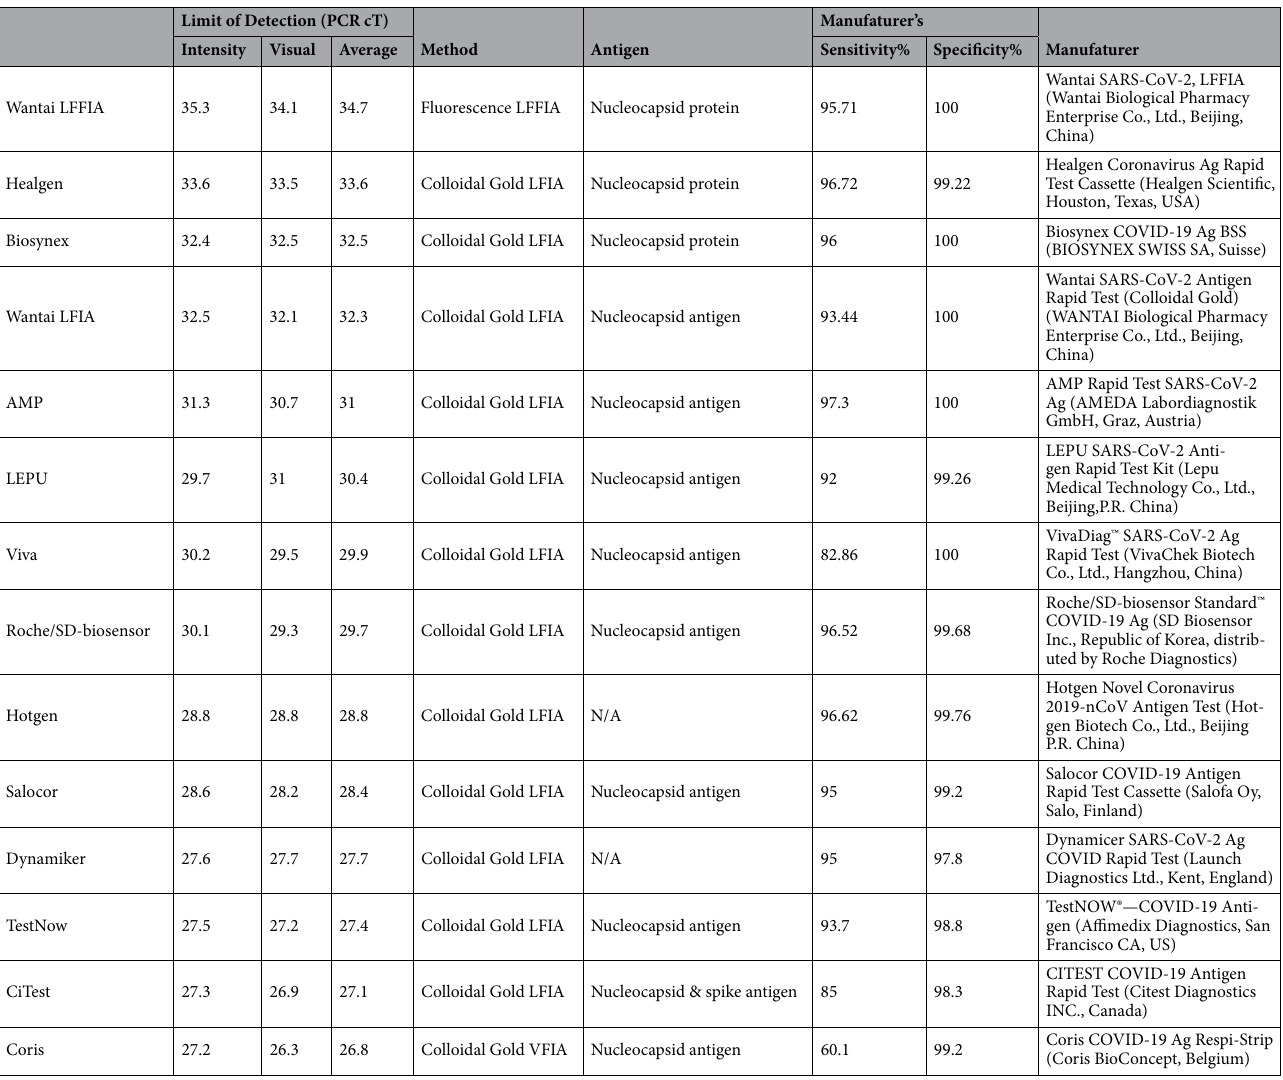
Table 1. Limit of detection and manufacturer’s characteristics of RATs. Intensity: LOD determined by digital scanning. Visual: LOD determined by visual inspection. LFIA lateral flow immunoassay, VFIA vertical